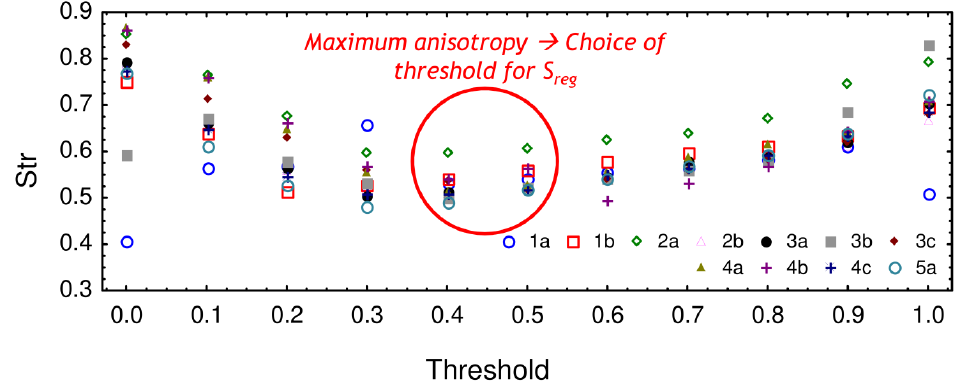
Figure 5. Texture aspect ratio S tr results as a function of the threshold value.